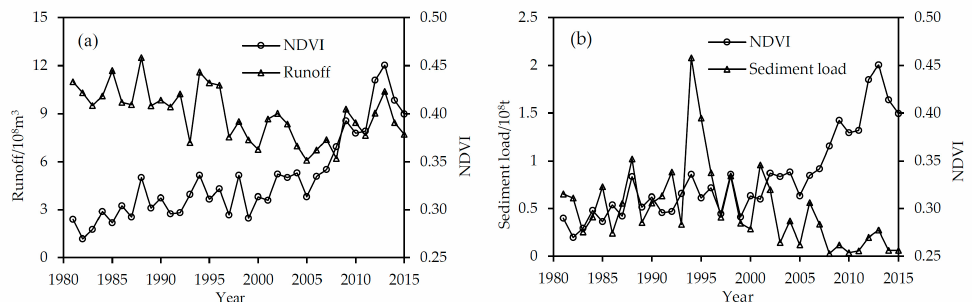
Figure 8. Variation in runoff (or sediment load) and NDVI in the Wuding River basin; ( a ) runoff and NDVI; ( b ) sediment load and NDVI.